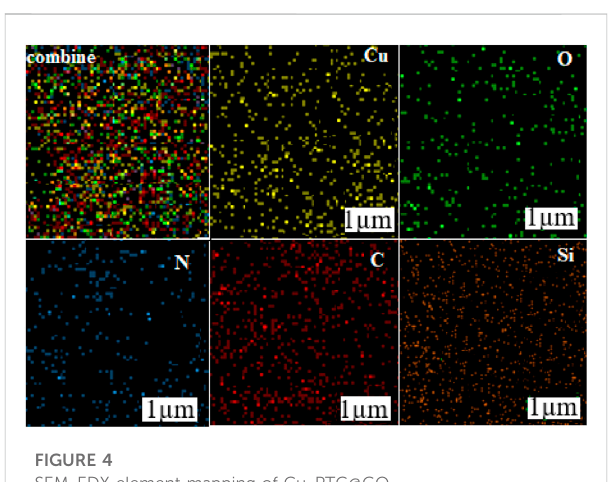
FIGURE 4 SEM-EDX element mapping of